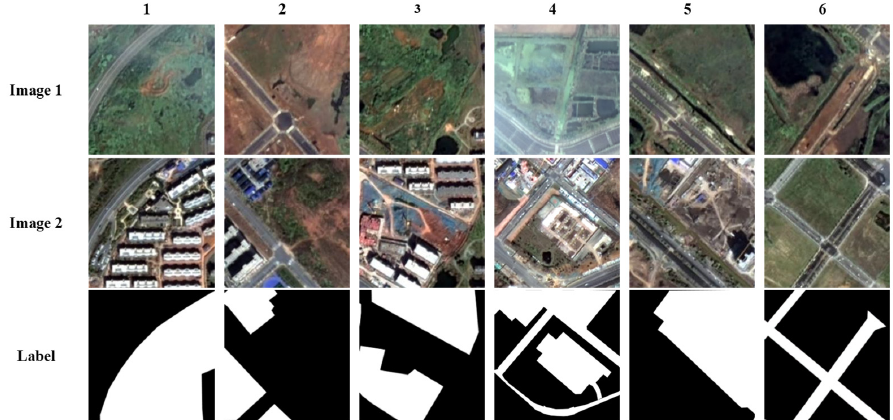
Figure 2. Examples of the original GF ‐ 2 images of 2015 and 2020 and their corresponding labels. Columns 1, 2, 3, 4 are the representations of change from vegetation or farmland or obvious non ‐ construction area to obvious building area, and Column 5 is the representation of change from veg